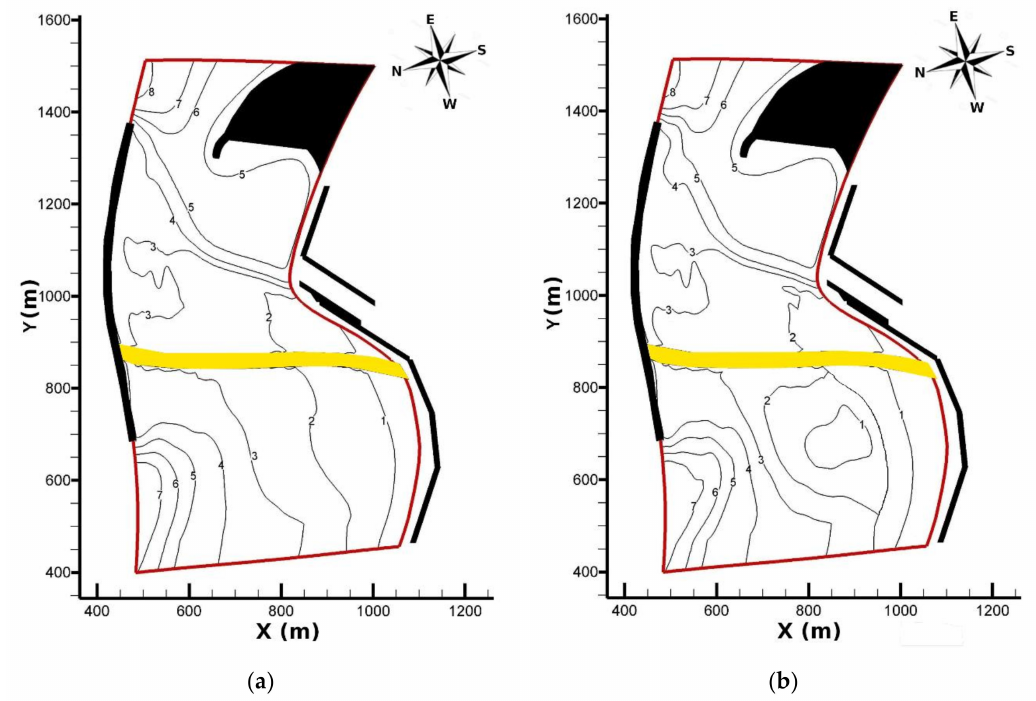
Figure 11. Configuration 2. Still water depth, measured from mean water level, after: ( a ) one year; and ( b ) three